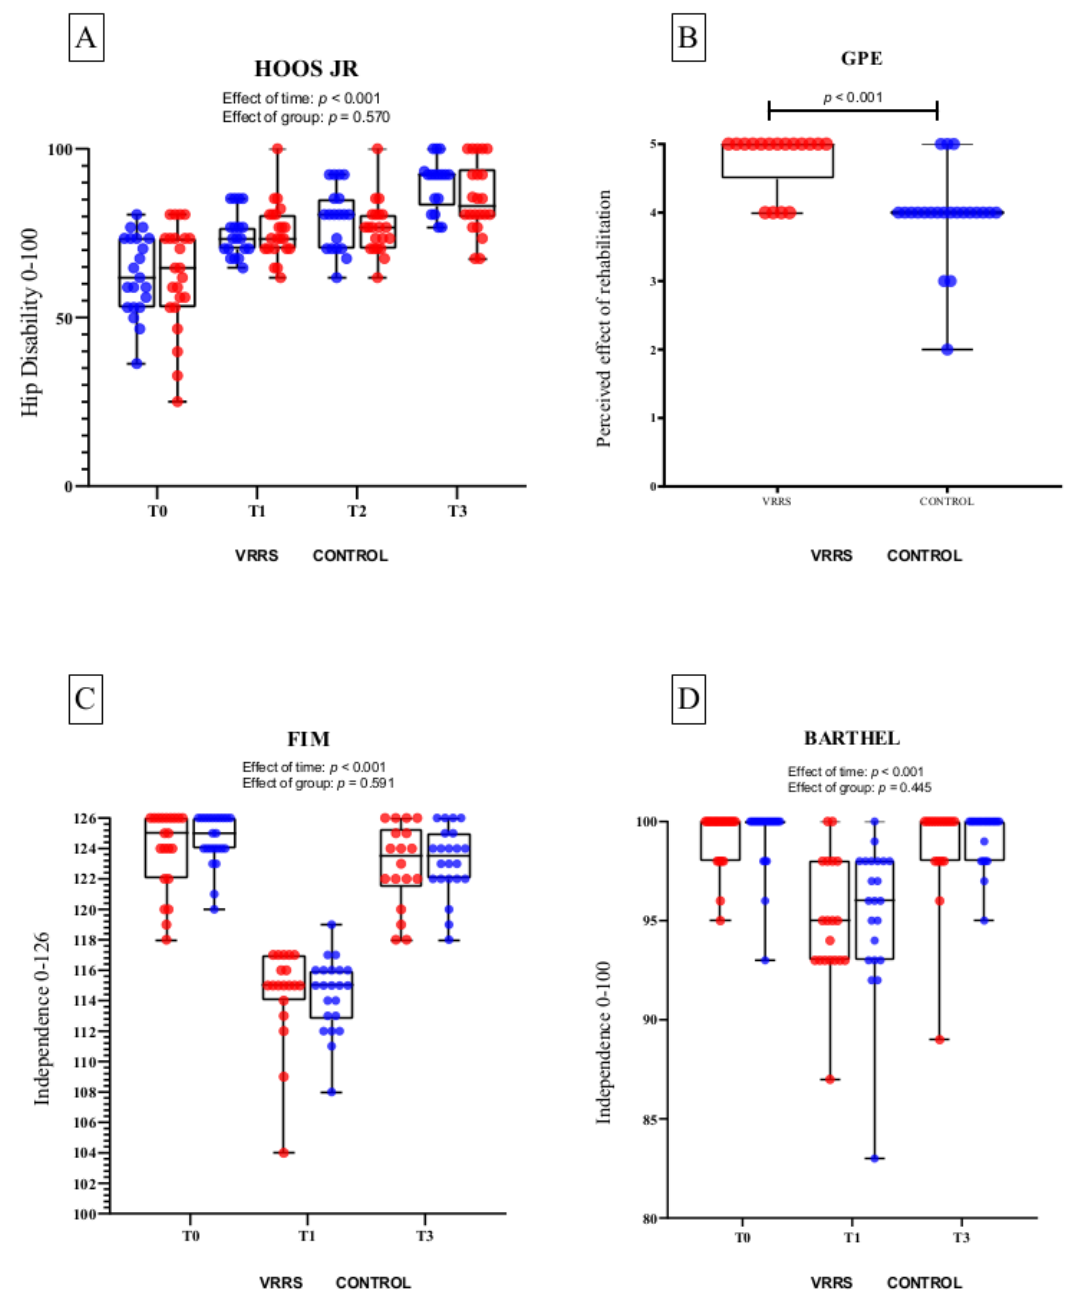
Figure 4. Whiskers box plots and single values of HOOS JR (panel A ), GPE (panel B ), FIM (panel C ), and Barthel (panel D ) scores for VRRS group (red circles) and control group (blue circles). HOOS JR: Hip dysfunction and Osteoarthritis Outcome Score for Joint Replacement (0–100); GPE: degree of perceived effect of the rehabilitation program (0–5); FIM: Functional Independence Measure (18–126); BARTHEL: Modified Barthel Index (0–100). Details on statistical differences for the effect of time are reported in Table 3.